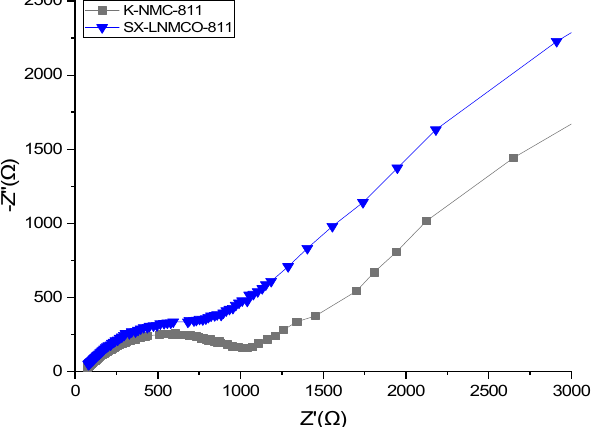
Figure 6. Nyquist plots of the one-cycle measurement of the batteries with cathode precursor vari ‐ ations.